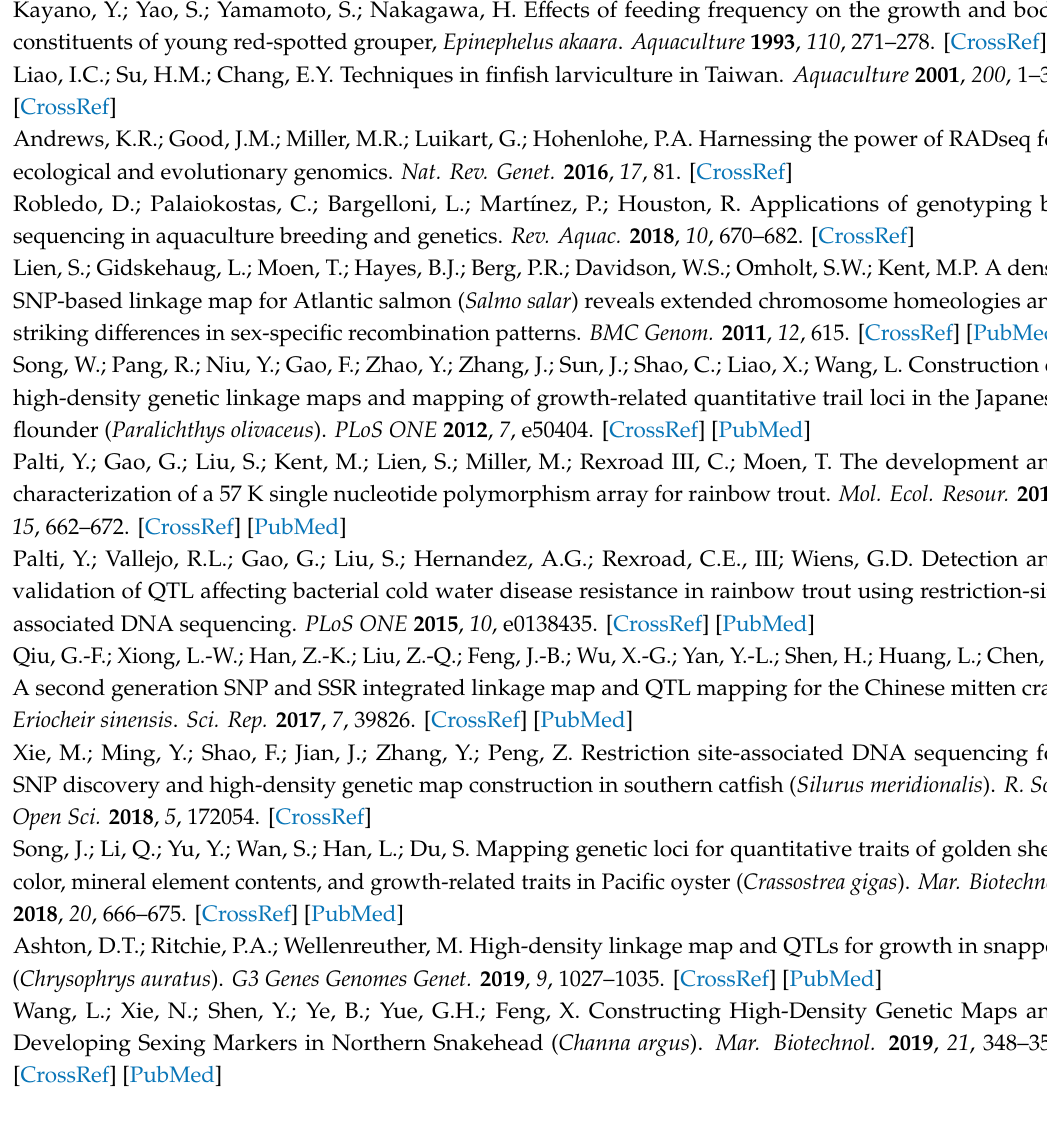
Figure S1: STRING interaction network showing association between di ff erentially expressed protein, Table S1: Phenotypic information, Table S2: The protein informations in the protein interaction networks (PPI), Table S3: Genetic maps construction for some fish species between 2015 and